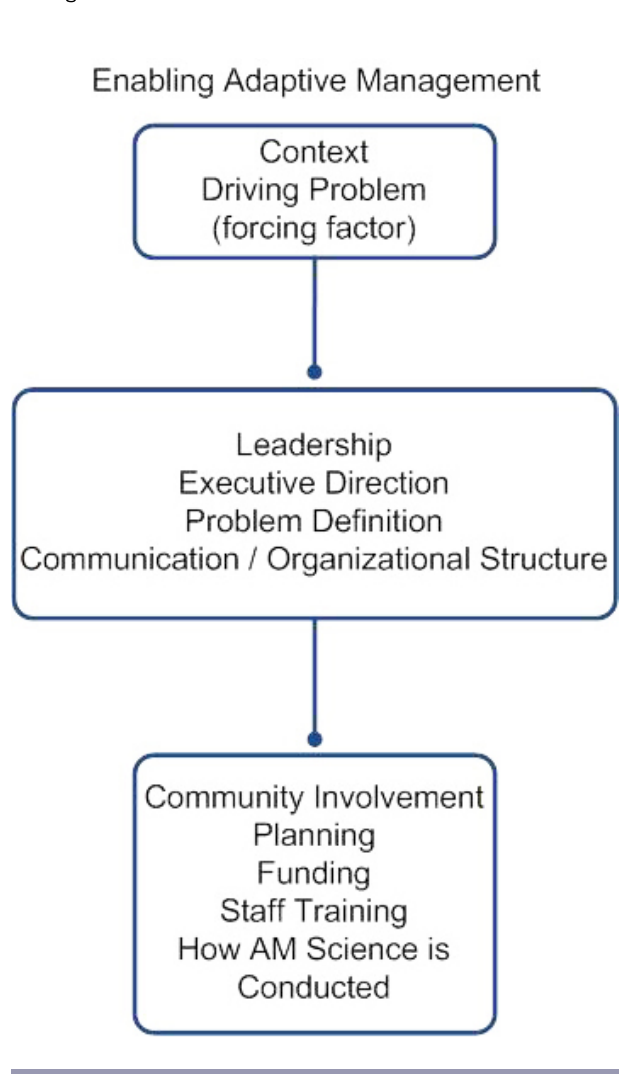
Fig. 1. Hierarchy of factors that enable adaptive management.